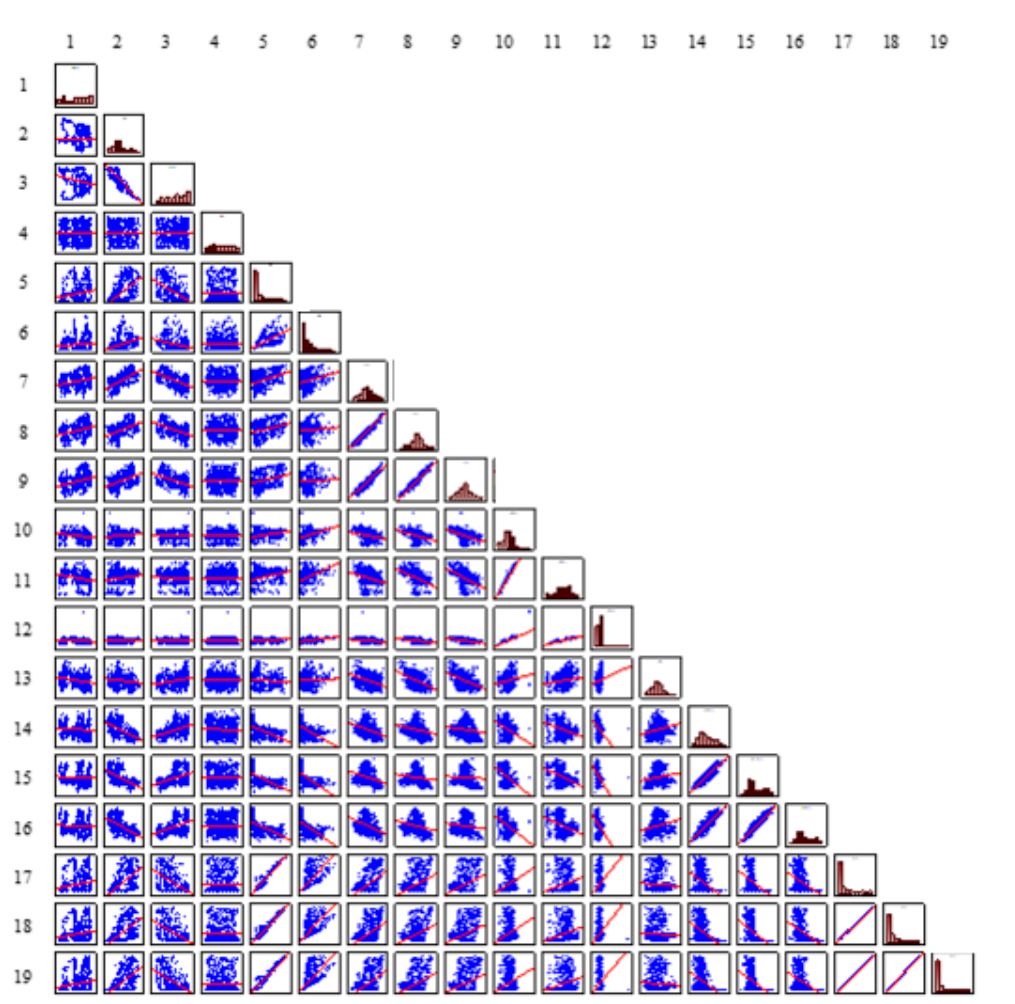
Figure 6. Correlation diagrams for all pairs of parameters (PQ and weather) when 10 min aggregation interval is used.